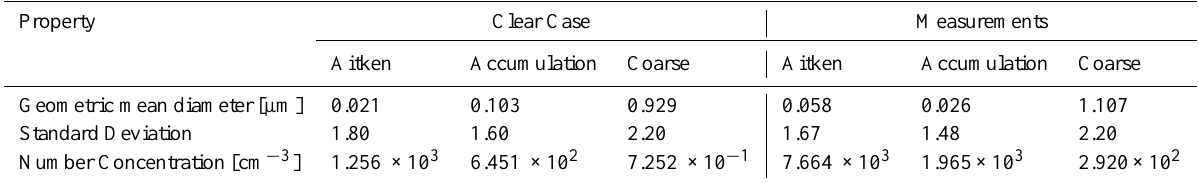
Table 6. Initial conditions of geometric mean diameter [µm], standard deviation and number concentration [cm − 3 ] for each mode of the PSD associated with clear atmospheric conditions and the average of observed PSD from the FMPS